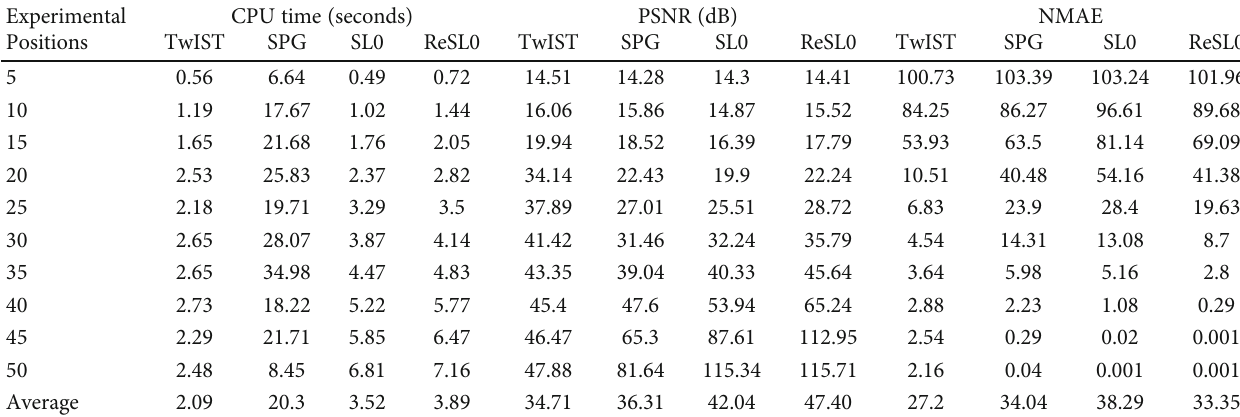
Table 2: Numerical results of reconstructed images.